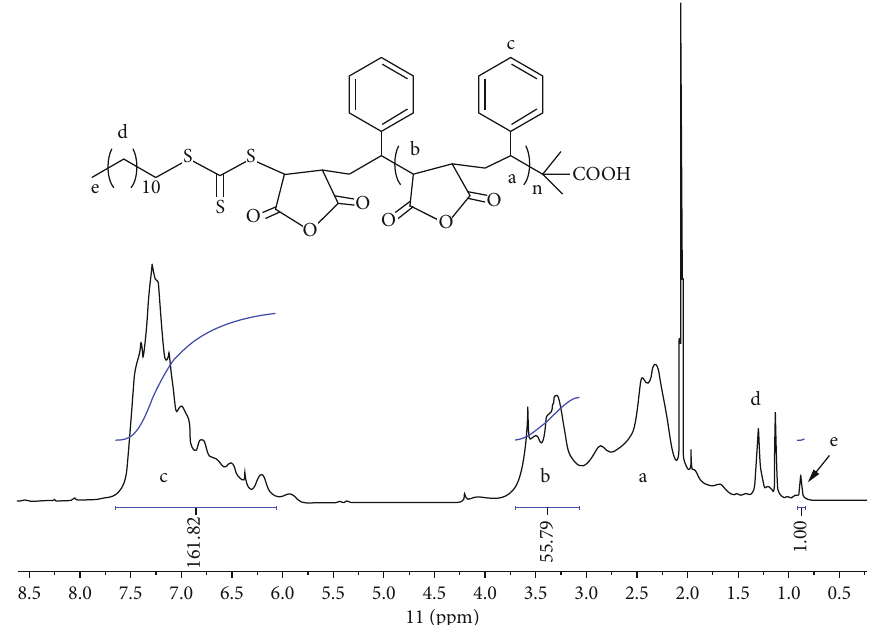
M M : 30 ) obtained from RAFT copolymerization of St and MAh initiated by Asc. n = 19100 , w / n = 1